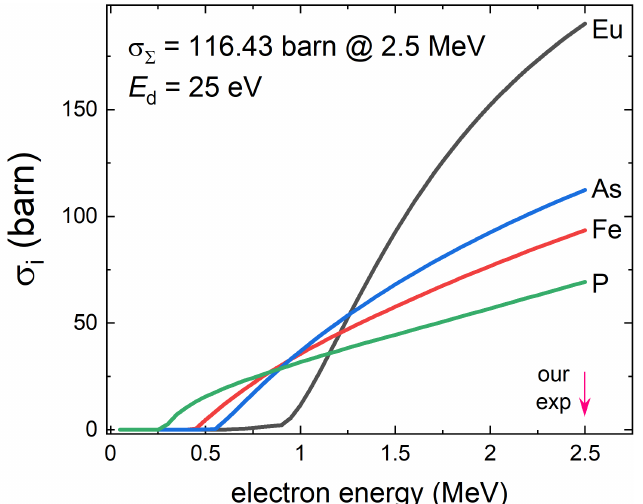
Figure 3. Defects creation cross-sections for different ions in EuFe 2 ( As 0.77 P 0.23 ) 2 as function of electron energy assuming the displacement energy threshold, E d = 25 eV. At 2.5 MeV, the partial cross-sections are P: 69.2 barn, Fe: 93.5 barn, As: 112.4 barn and Eu: 190.3 barn. The total cross- section of defects creation is estimated as 116.4 barn, which leads to the estimate of the 7.3 × 10 − 4 displacements-per-atom (dpa) per 1 C/cm 2 of the